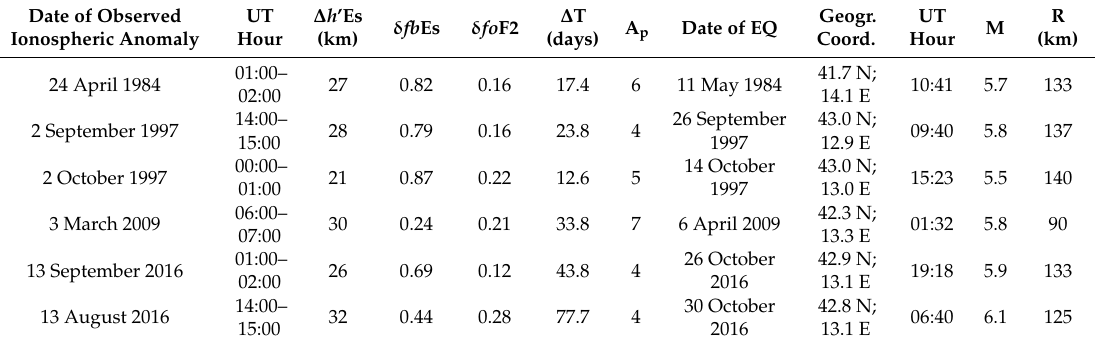
Table 2. Identified ionospheric anomalies and corresponding EQs. Daily A p indices are given as well. Date of Observed Ionospheric